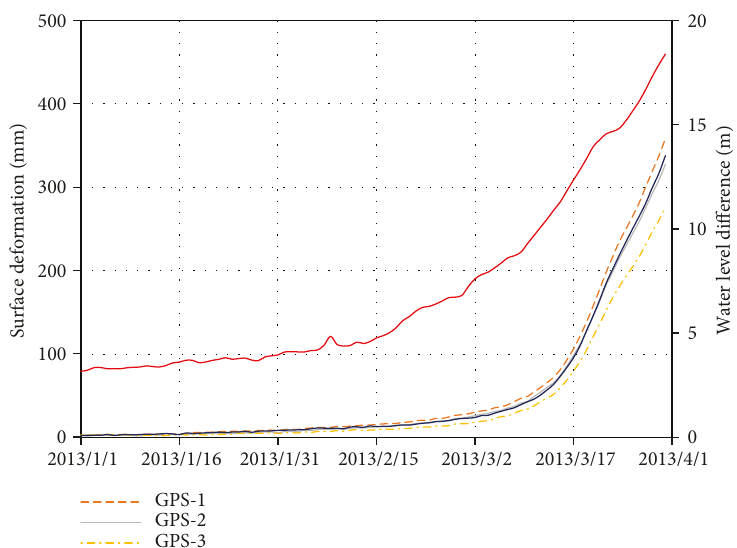
Figure 13: Water level di ff erence inside and outside the slope versus surface measurements by